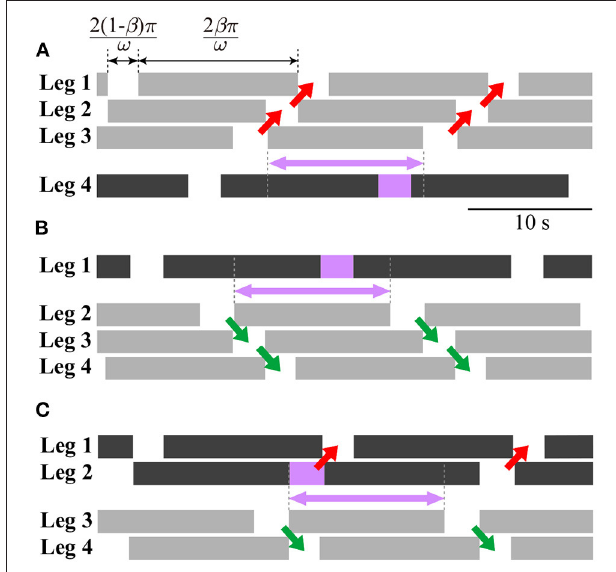
FIGURE 6 | Footprint diagrams of periodic solutions: (A) Direct-wave gait (point a in Figure 4 ), (B) retrograde-wave gait (point b in Figure 4 ), and (C) source-wave gait (point c in Figure 4 ). Black bars can change to gray bars as long as the violet box is in the range indicated by the violet